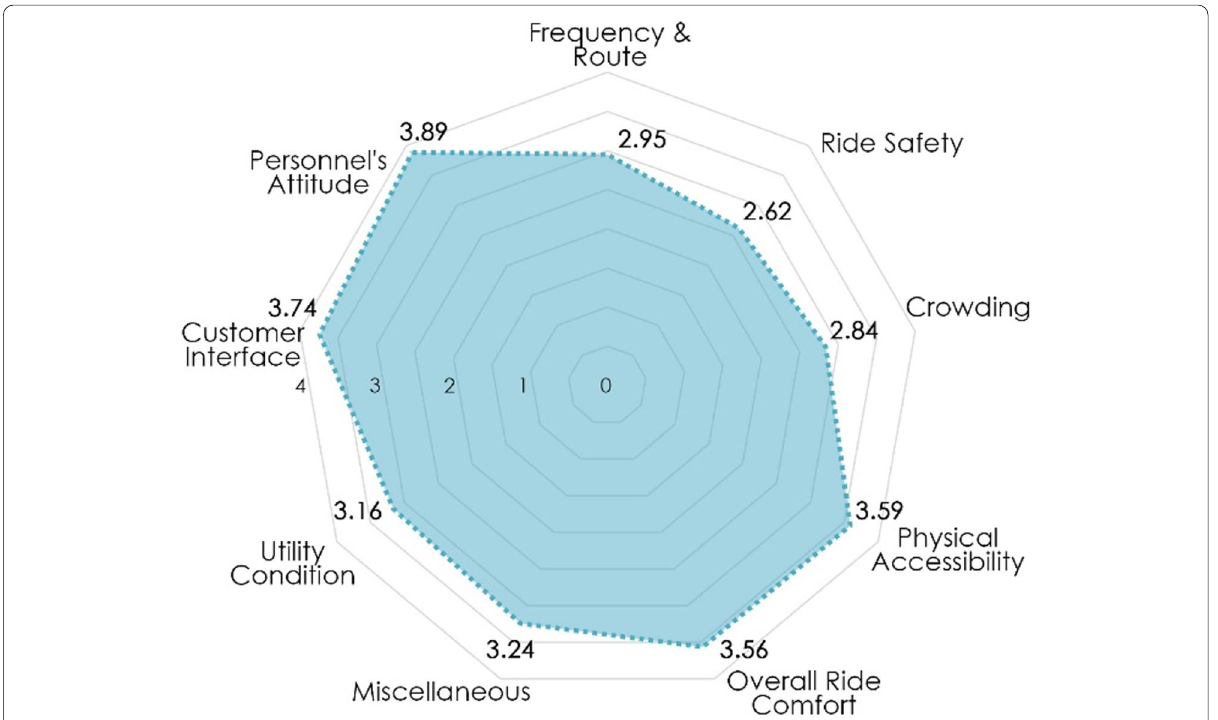
Fig. 6 Final scoring for the predicted topics. Source: Author